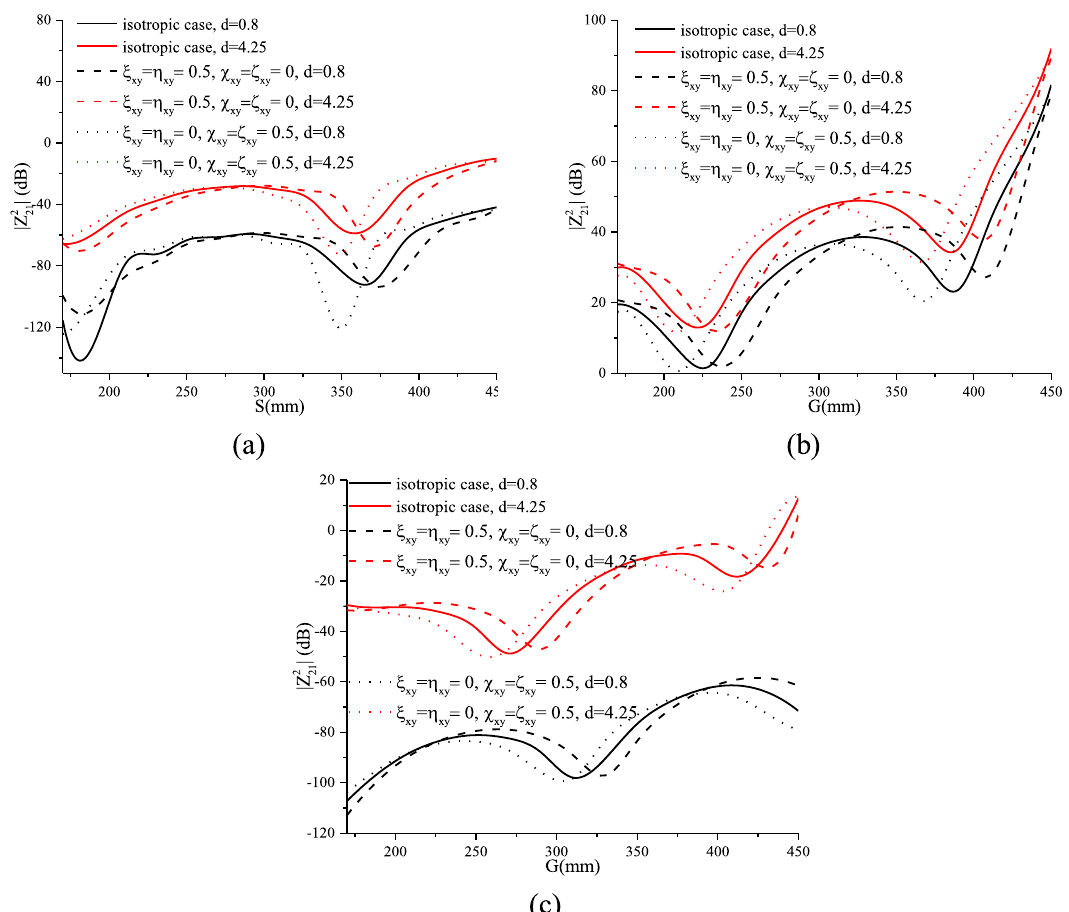
Figure 17. Mutual coupling for different substrate thicknesses for ( a ): broadside, ( b ): collinear and ( c ) echelon hand, the effect of the magnetoelectric elements, whether imaginary (chiral) or real (Tellegen), keeps the same proportion with respect to the isotropic case for the two selected cases (d = 0.8 and d = 4.25). Effect of the magneto‑electric parameters on the field’s distributions. The electric field distri- butions in the XY, XZ and YZ planes are shown in Fig. 18a–c. The field distributions illustrate a conventional isotropic dipole with the XZ plane as the E plane. Similarly, the distributions of the magnetic field in the XY, XZ and YZ planes are presented in Fig. 18d,e. We observe rotating lines of the magnetic field around the dipole in the YZ plane (the H plane) according to Fig. 18e. The electric and magnetic field distributions in the XY, XZ and YZ planes are shown in Fig. 19a–f, respectively. The lines of the electromagnetic field for this case have not changed and have kept the shape of the conventional